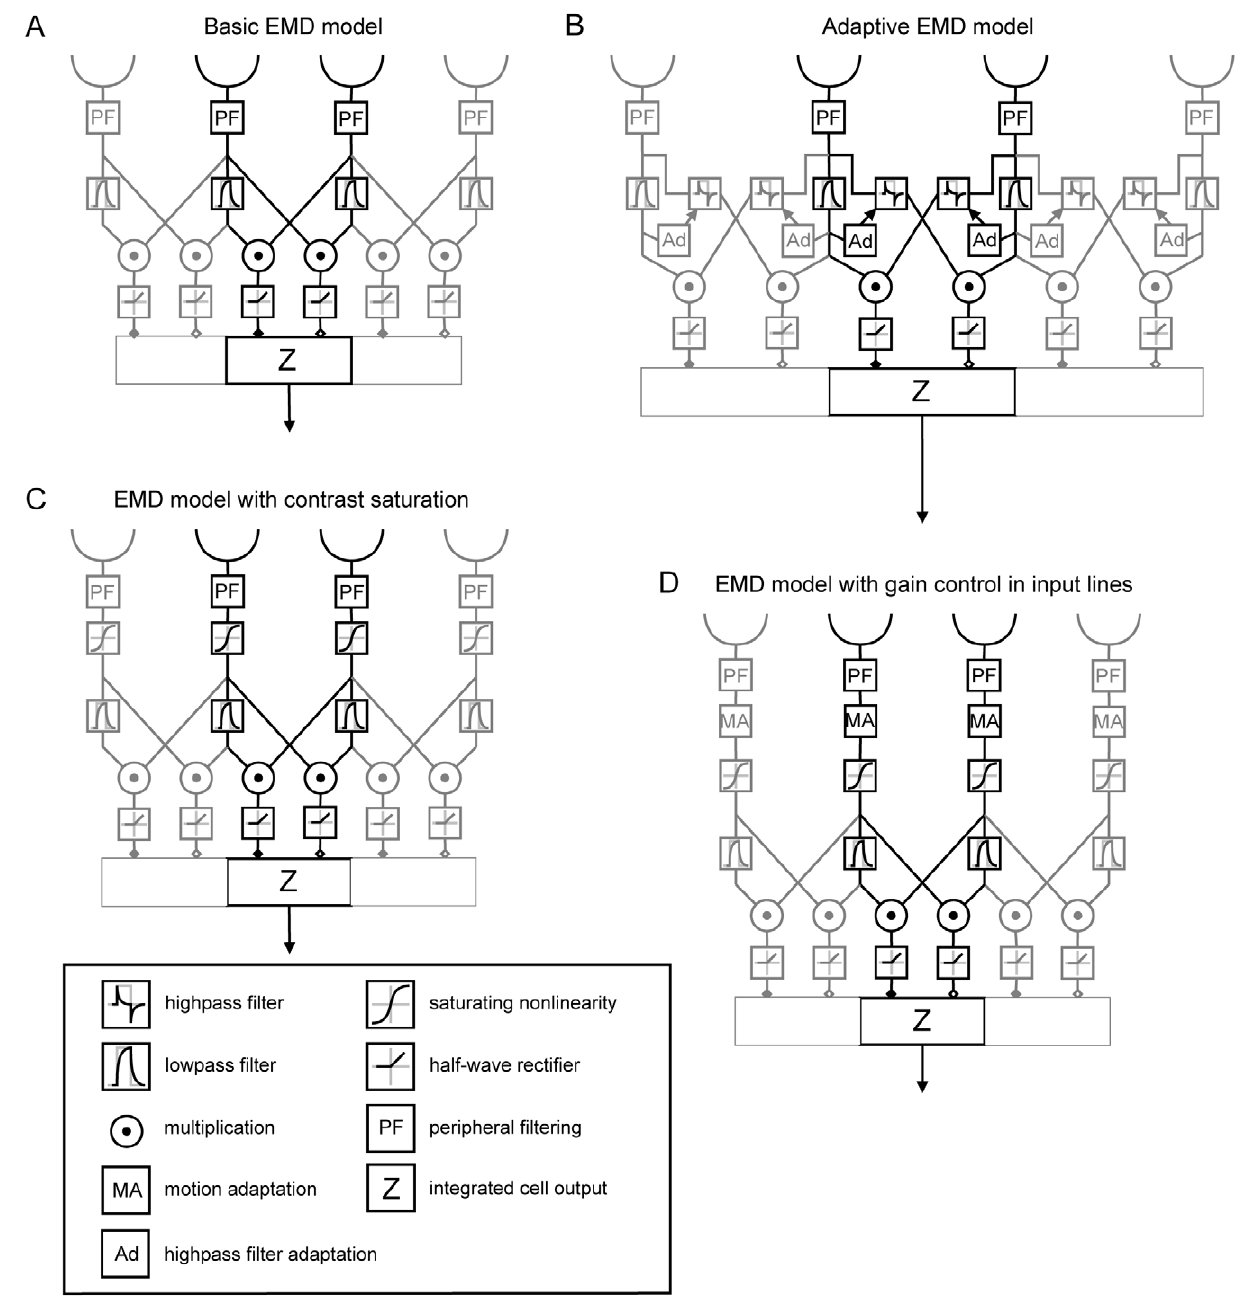
Figure 1. EMD array models used for simulation of LPTC response. (A) Basic EMD model including peripheral filtering ( PF ) in the input stage (see Methods and Materials). Signals from each receptor are delayed via the phase delay of a temporal first-order low-pass filter, multiplied and half-wave rectified. Integration of signals in the output cell Z is performed according to the gain control model [13]. (B) Adaptive EMD model extended with a first-order high-pass filter in the cross-arms of the half-detectors. The time-constant of the high-pass filter is adjusted according to the rate of change of the corresponding low-pass signal [14]. (C) EMD model with contrast saturation during early visual processing in the input stage. Saturating non-linearities are included to mimic contrast saturation during early visual processing [15]. (D) EMD model with gain control in the input lines [8]. The input from each receptor channel is divided by the mean absolute deviation (see Methods and Materials) in order to control the gain in the input